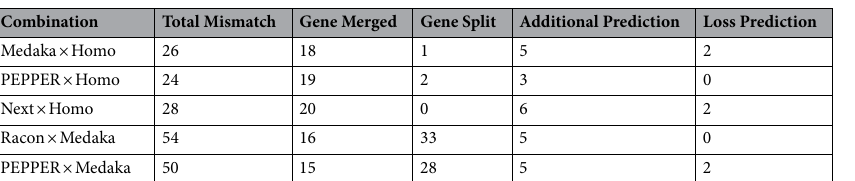
Table 4. Summary of the number of differences and types in Prokka predicted genes in combination polishing compared to short-read pilon polishing.